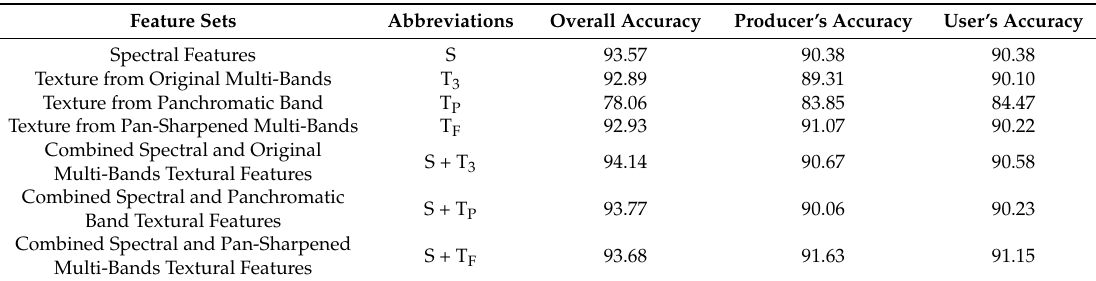
Table 3. The classification accuracy of different features